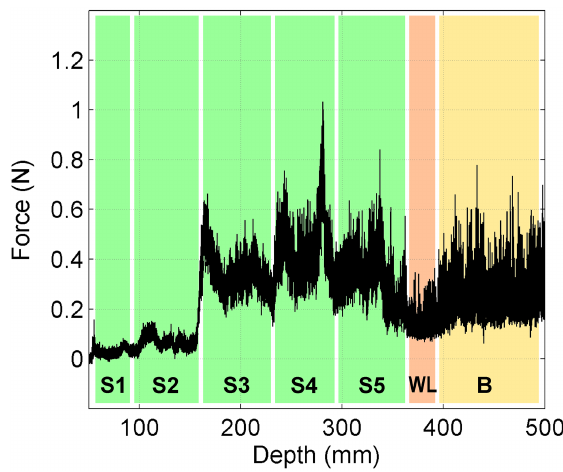
Figure 3. Penetration resistance (black) as measured with the SMP vs. snow depth. Slab layers (S1–S5) shaded in light green, weak layer (WL) shaded in light red, basal layer (B) shaded in light or- ange. 50mm of air signal cut